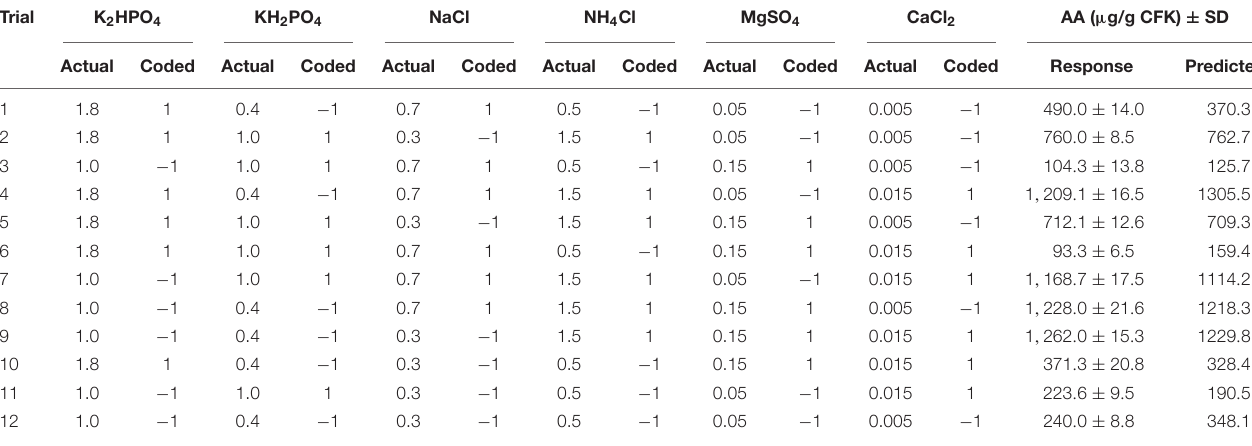
TABLE 1 | The Plackett–Burman design with the actual (mg/g CFK) and codified values of the tested medium components of B. paramycoides ZW-5 and the corresponding keratinolytic activity and amino acids. Trial K 2 HPO